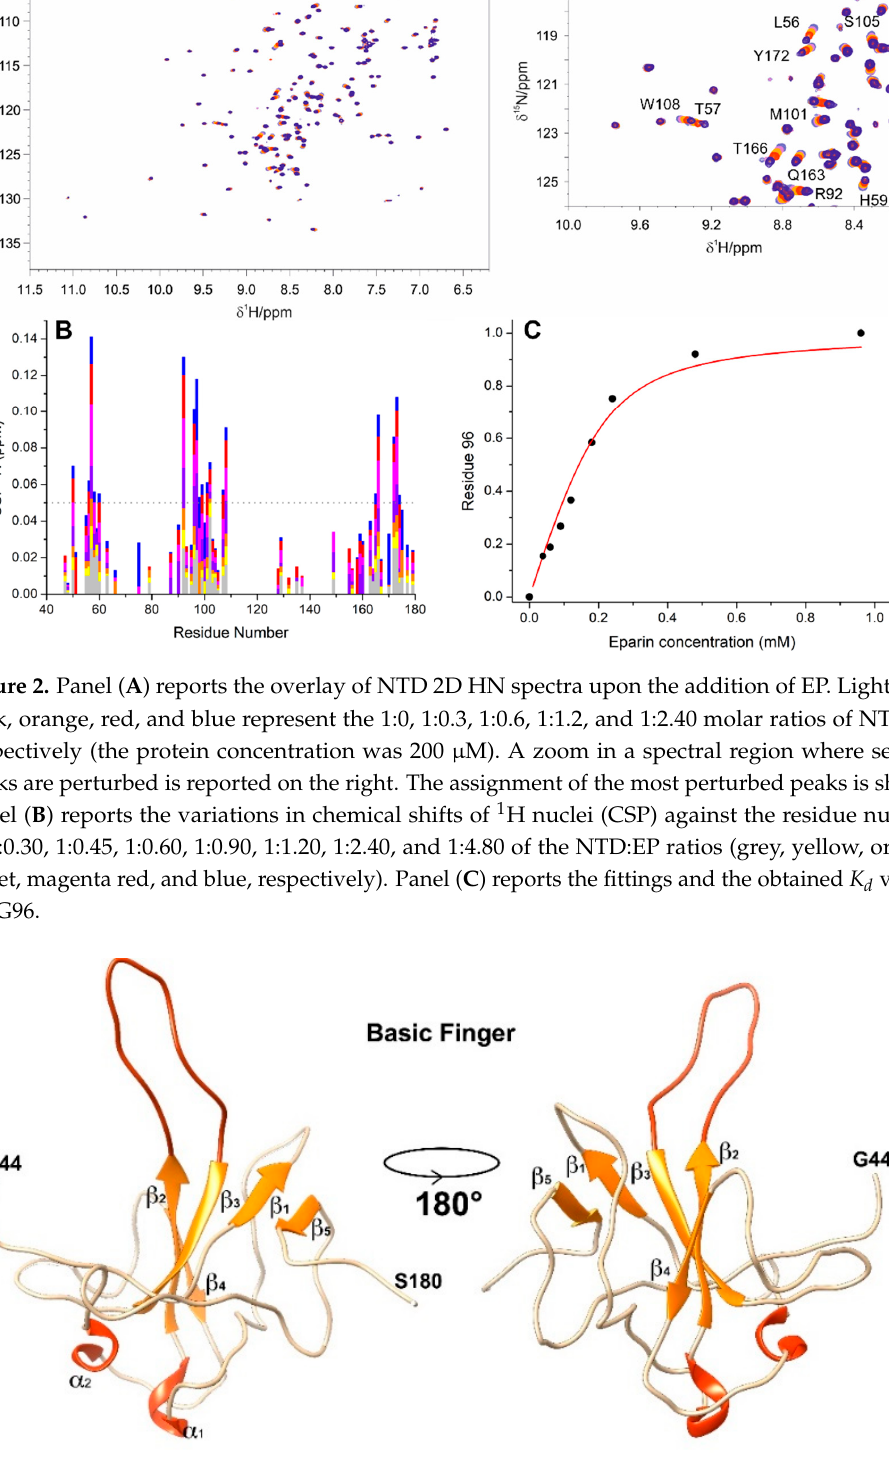
Figure 3. Representation of the secondary structural elements forming the fold of the NTD. β sheets are reported in orange together with the loop composing the finger. α helices are reported in red. The elements that are not comprised in any secondary structural element are reported in